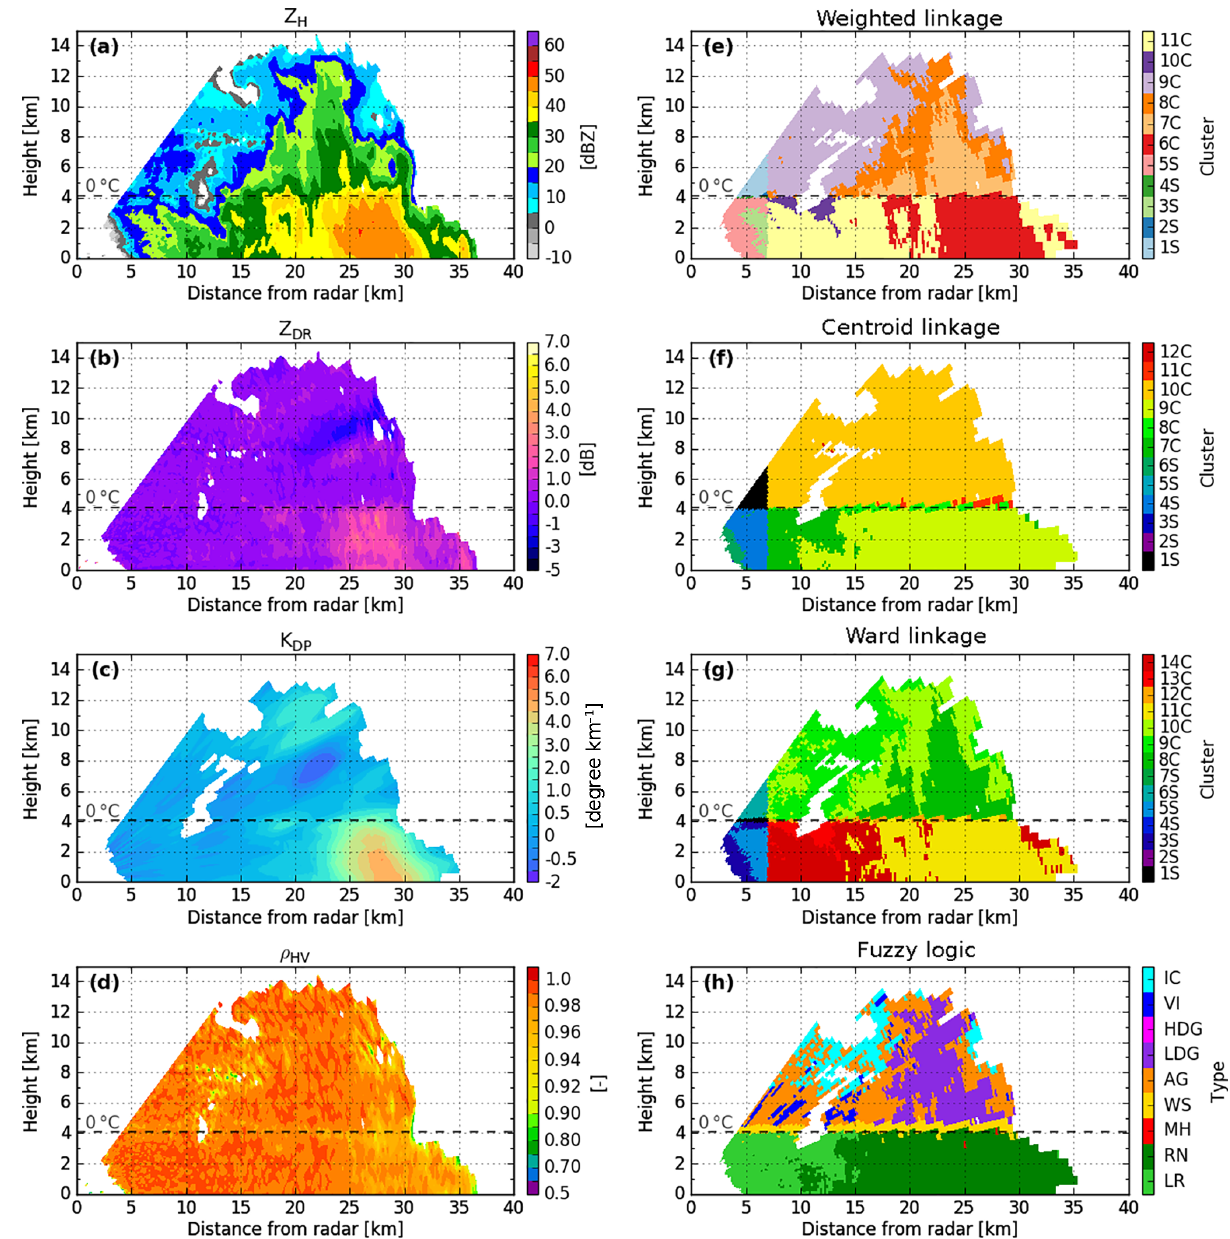
Figure 5. Same as Fig. 4, but for 13:57UTC on 13 February 2014, along the azimuth 200 ◦